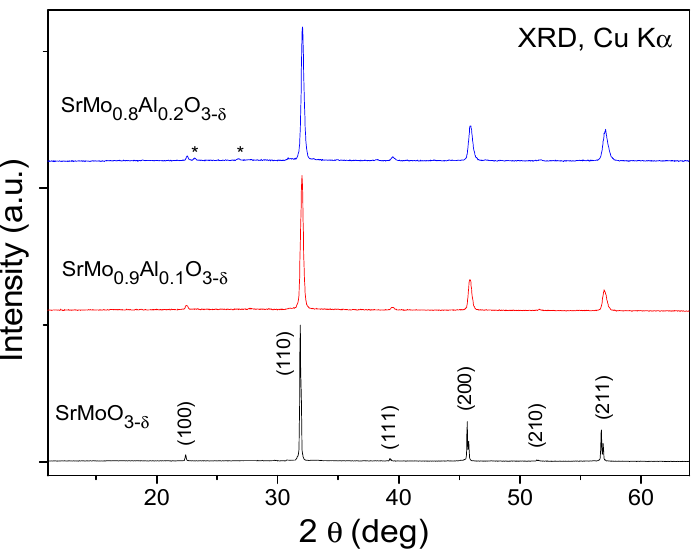
Figure 1. The XRD patterns with CuK α radiation for SrMo 1 − x Al x O 3 − δ (x = 0, 0.1 and 0.2). The asterisks correspond to a tiny impurity of Sr8(Al 12 O 24 )(MoO 4 ) 2 with sodalite structure (space group I 4 1 / acd ).